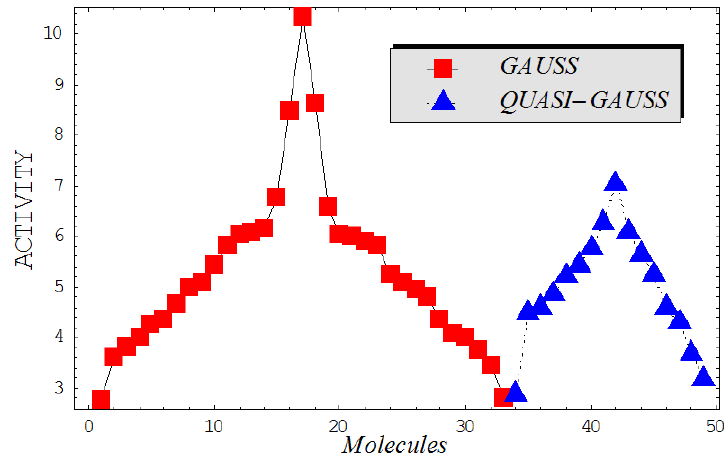
Figure 2. Graphical representation of the working activities for molecules in Tables 1 and 2, classified under the “Gaussian” and “quasi-Gaussian” series for the training and testing QSARs,